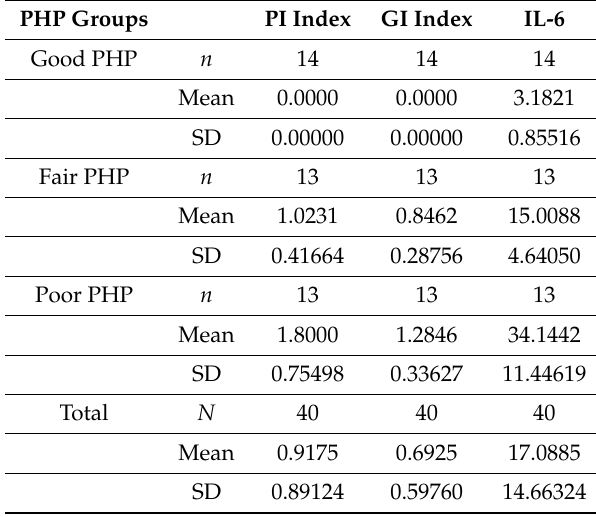
Table 2. Descriptive statistics based on PHP groups of PI, GI, and Interleukin-6( IL-6 ) expressed as mean value with Standard Deviation (SD ).